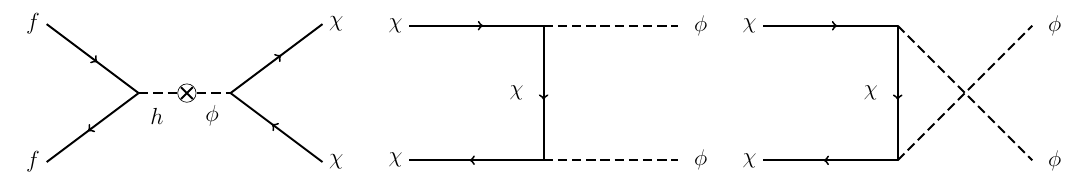
Figure 1 . Leading Feynman diagrams giving rise to non-thermal (cid:31) freeze-in production from SM annihilation during the early universe (left) and reannihilation into dark sector mediators (cid:30) (middle, right) once the hidden sector thermalizes with itself. Although the SM initiated process must be slower than Hubble expansion to avoid thermalizing the dark sector, the (cid:31) achieve chemical equilibrium at a separate temperature set by the energy density transmitted to the dark sector via the left diagram and those depicted in (cid:12)gure 2.